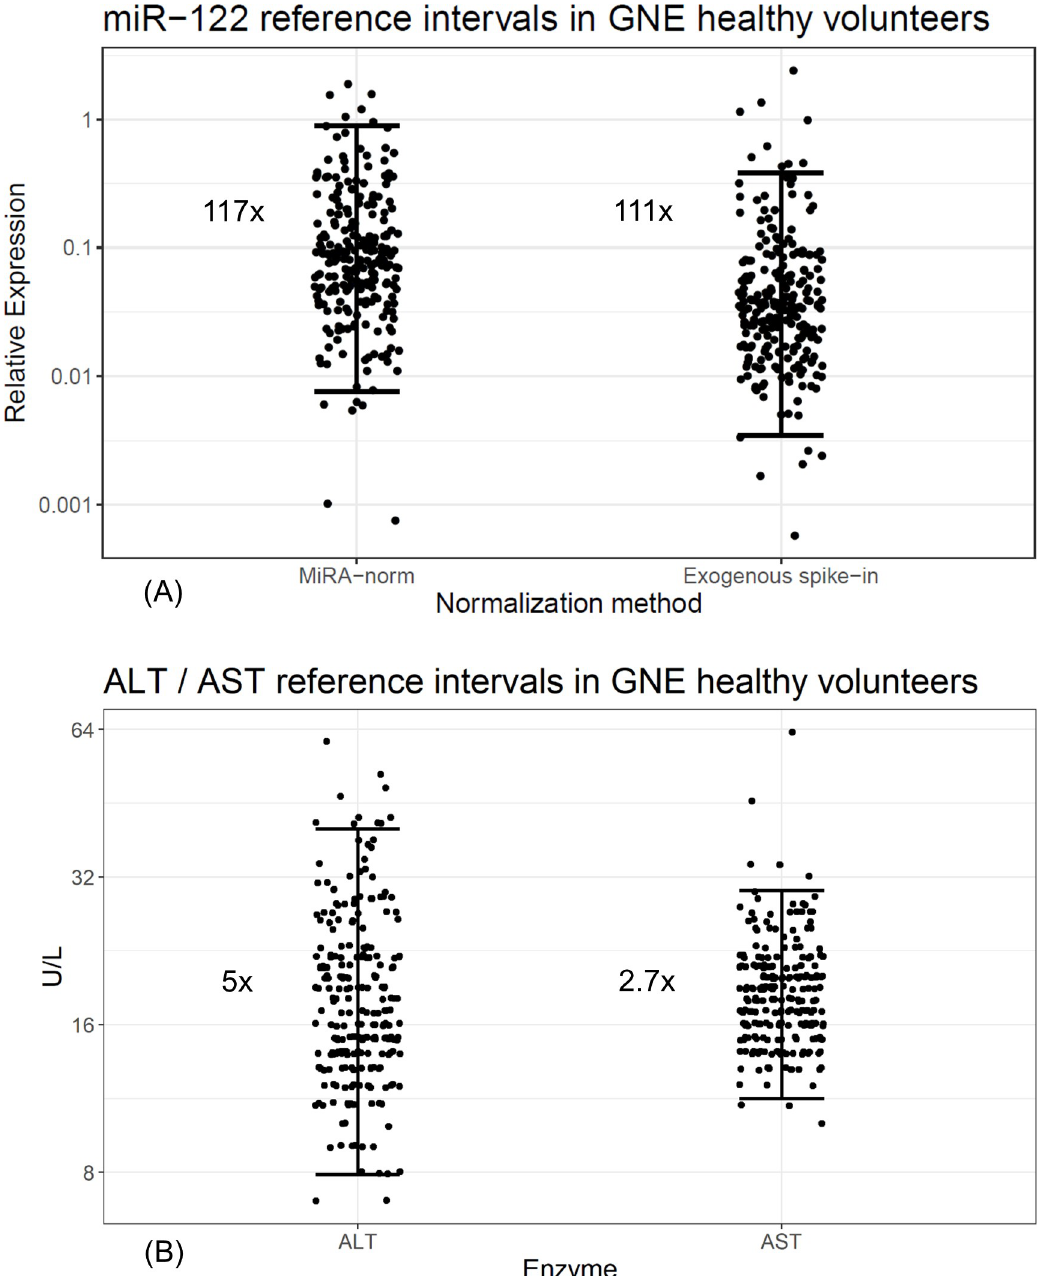
Fig 2. The 95% confidence reference ranges of miR-122, alanine transaminase (ALT), and aspartate transaminase (AST) in serum from healthy volunteers. (A) The relative serum expression of miR-122 normalized to the mean expression of a panel of five endogenous miRNAs (“MiRA-norm”, left) or to the exogenous C eleg miR-39 exogenous spike-in (right). Brackets represent the 95% confidence reference ranges for miR-122 serum expression, where miR-122 relative expression spanned 117- and 111-fold when normalizing to miRNA-norm or to C eleg miR-39 expression, respectively. (B) Serum expression of ALT (left) and AST (right) and their corresponding reference ranges. The reference range for ALT and AST were determined to be 5.0- and 2.7-fold,